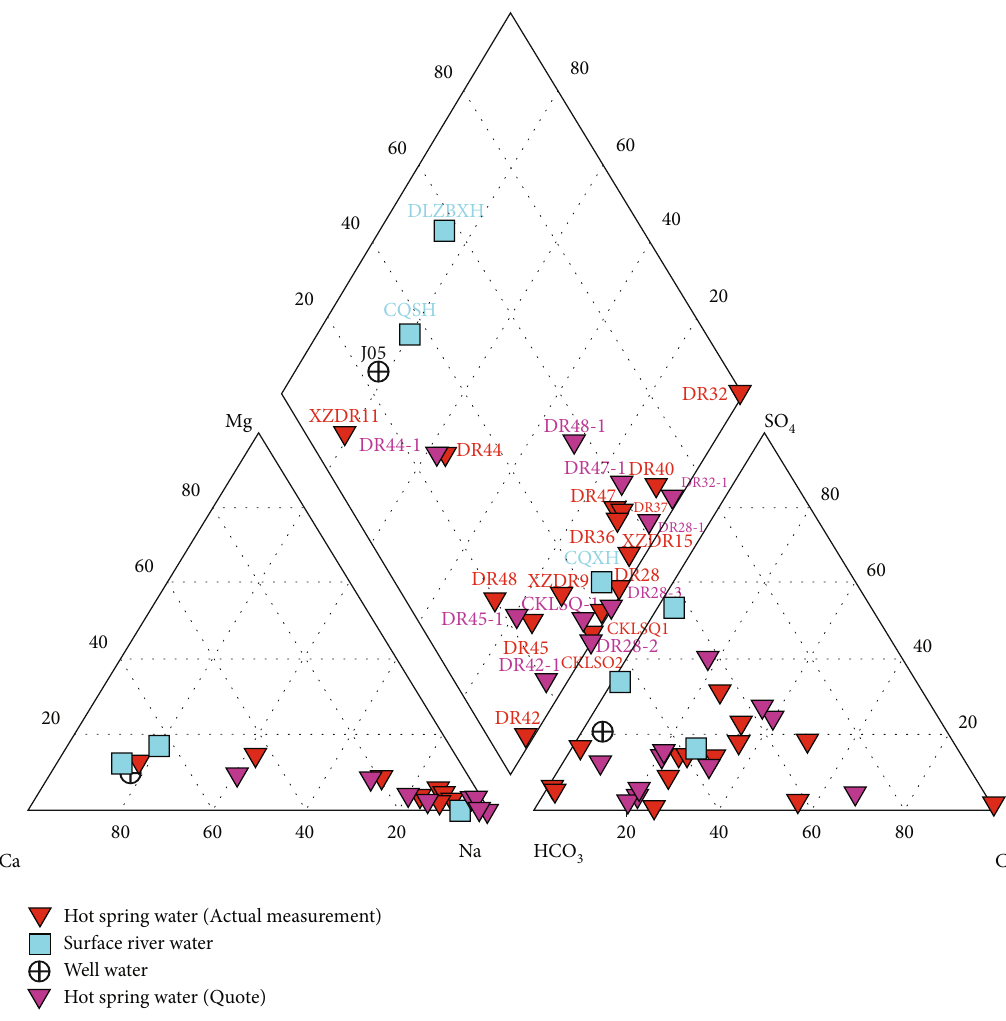
Figure 2: Chemical piper diagram of the water